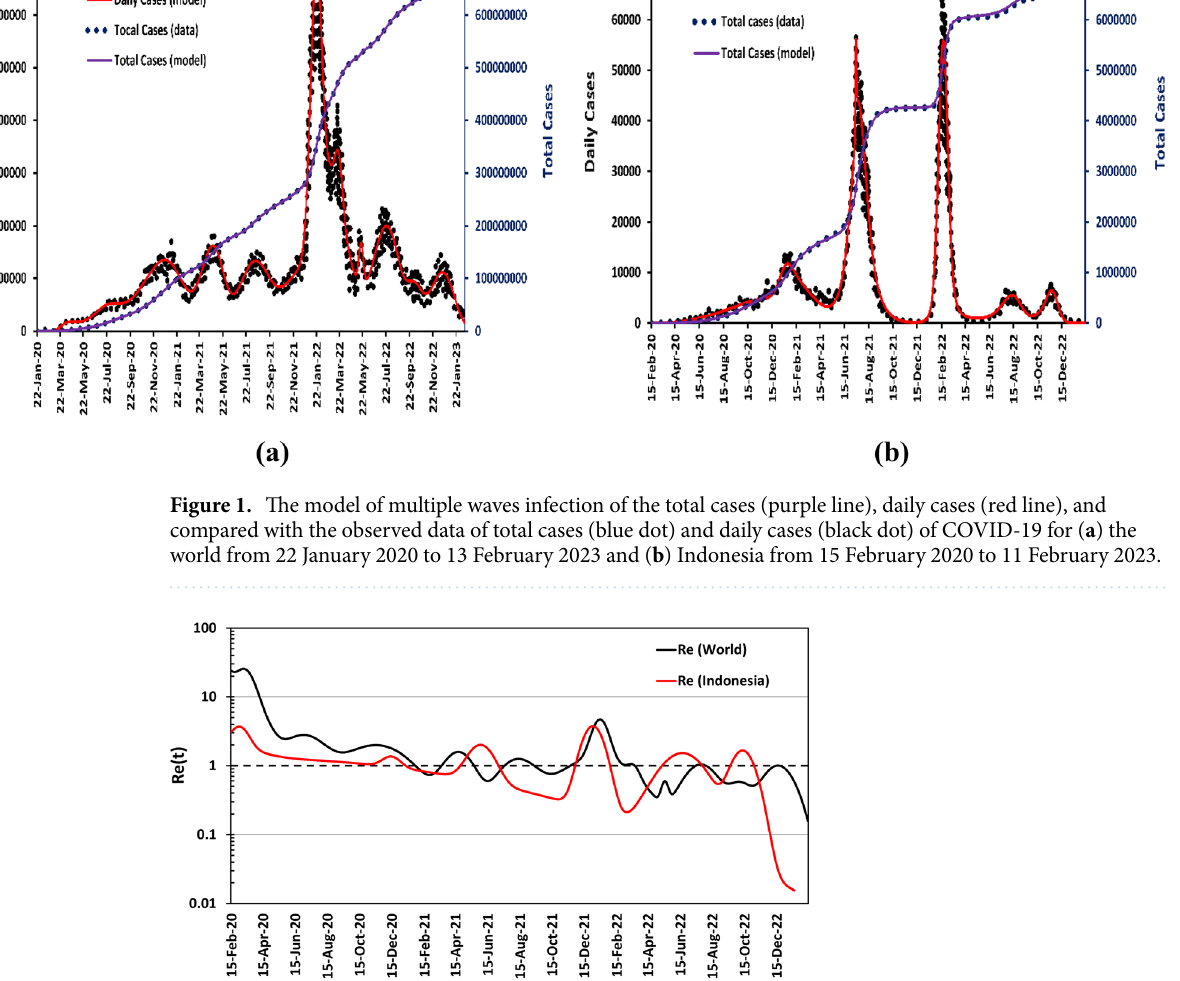
Figure 2. The effective reproduction number of COVID-19 for the world (black line) and Indonesia (red